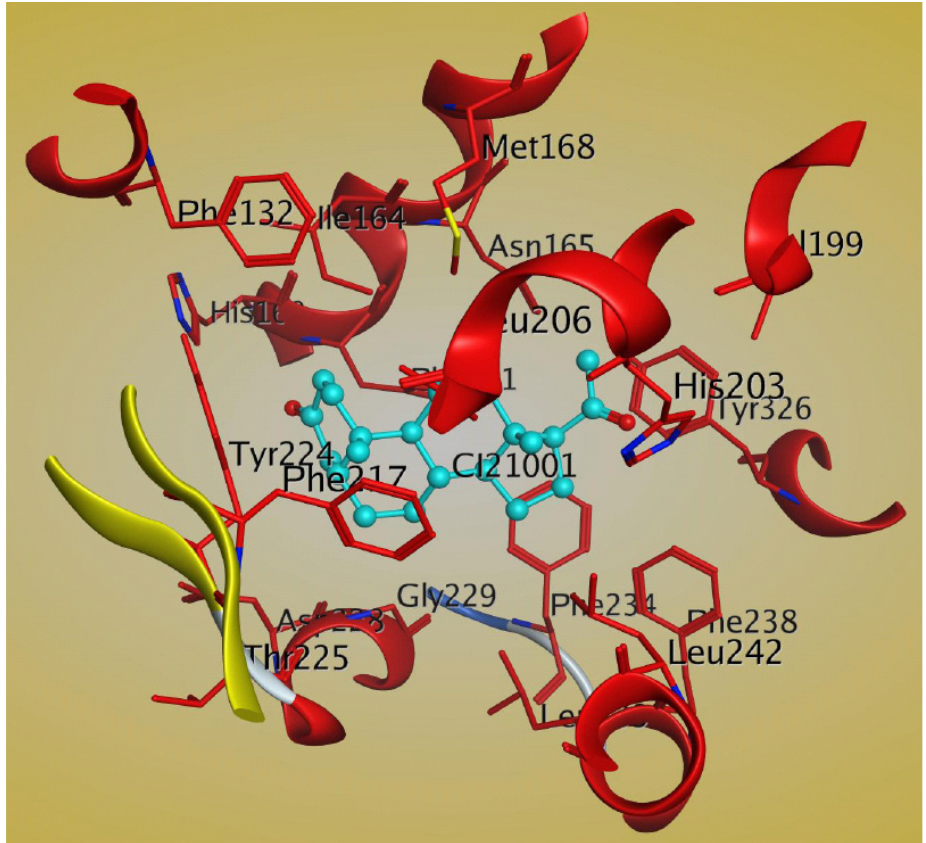
Figure 7. Structural analysis of the interactions between mCAR LBD and 5 β -pregnane-3,20-dione (cyan) within the ligand binding pocket, as shown by MOE software (PDB:1XV9). The important residues of CAR are shown in red. The figure was generated by using MOE